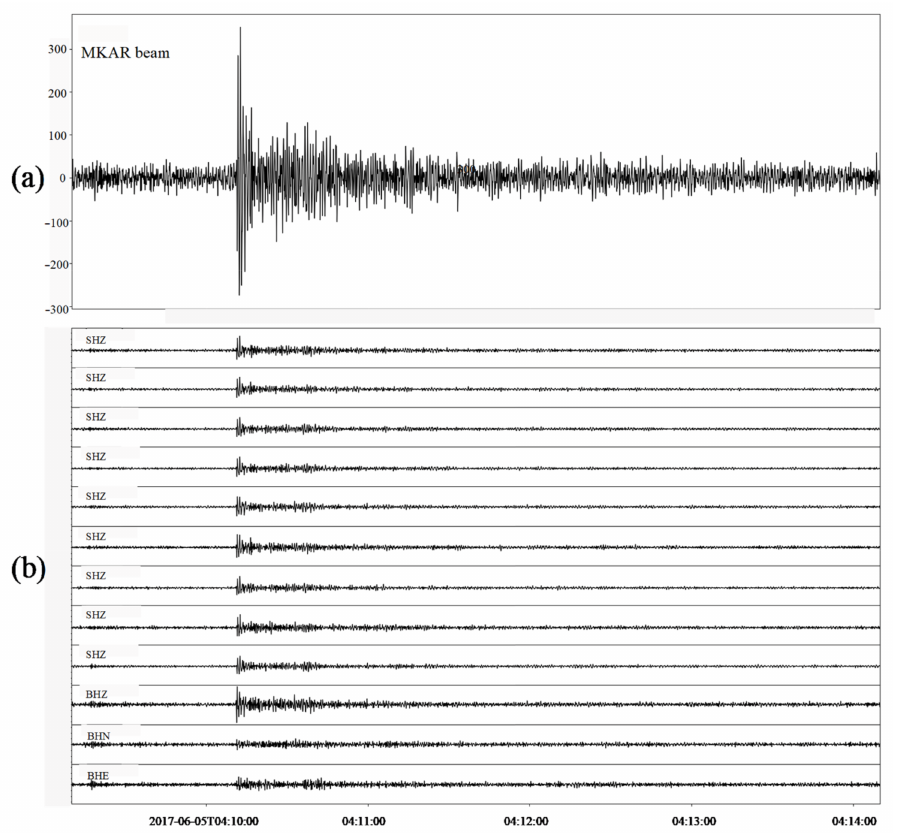
Figure 3. Comparison of the individual subsite waveforms and beamforming waveforms. ( a ) beam- forming waveform. ( b ) vertical channel waveform of each site of MKAR.